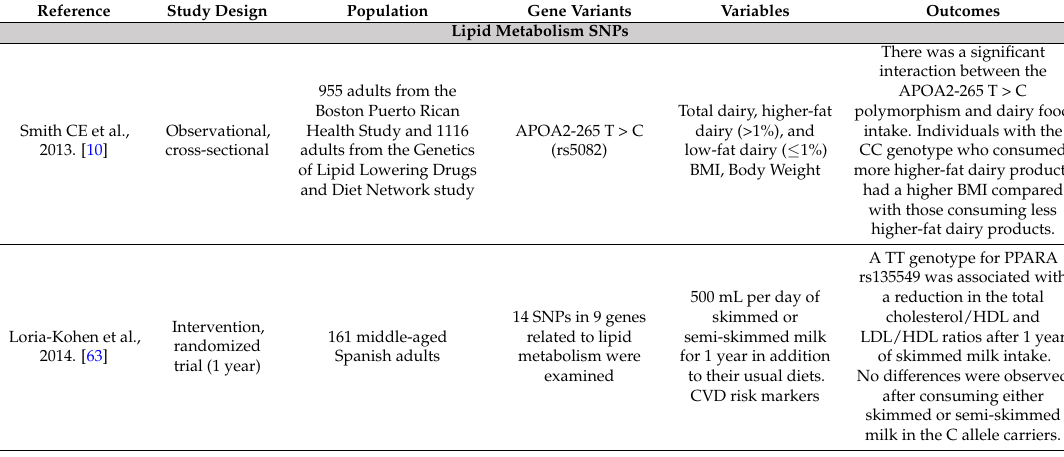
Table 2. Nutrigenetic studies on non-lactase polymorphisms, dairy intake, and health outcomes in